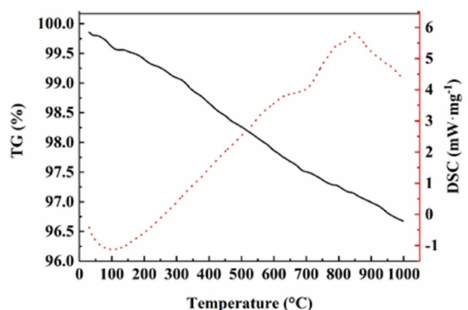
Figure 4. The thermogravimetric (TG) and di ff erential scanning calorimetry (DSC) curves of basalt fiber in an Ar